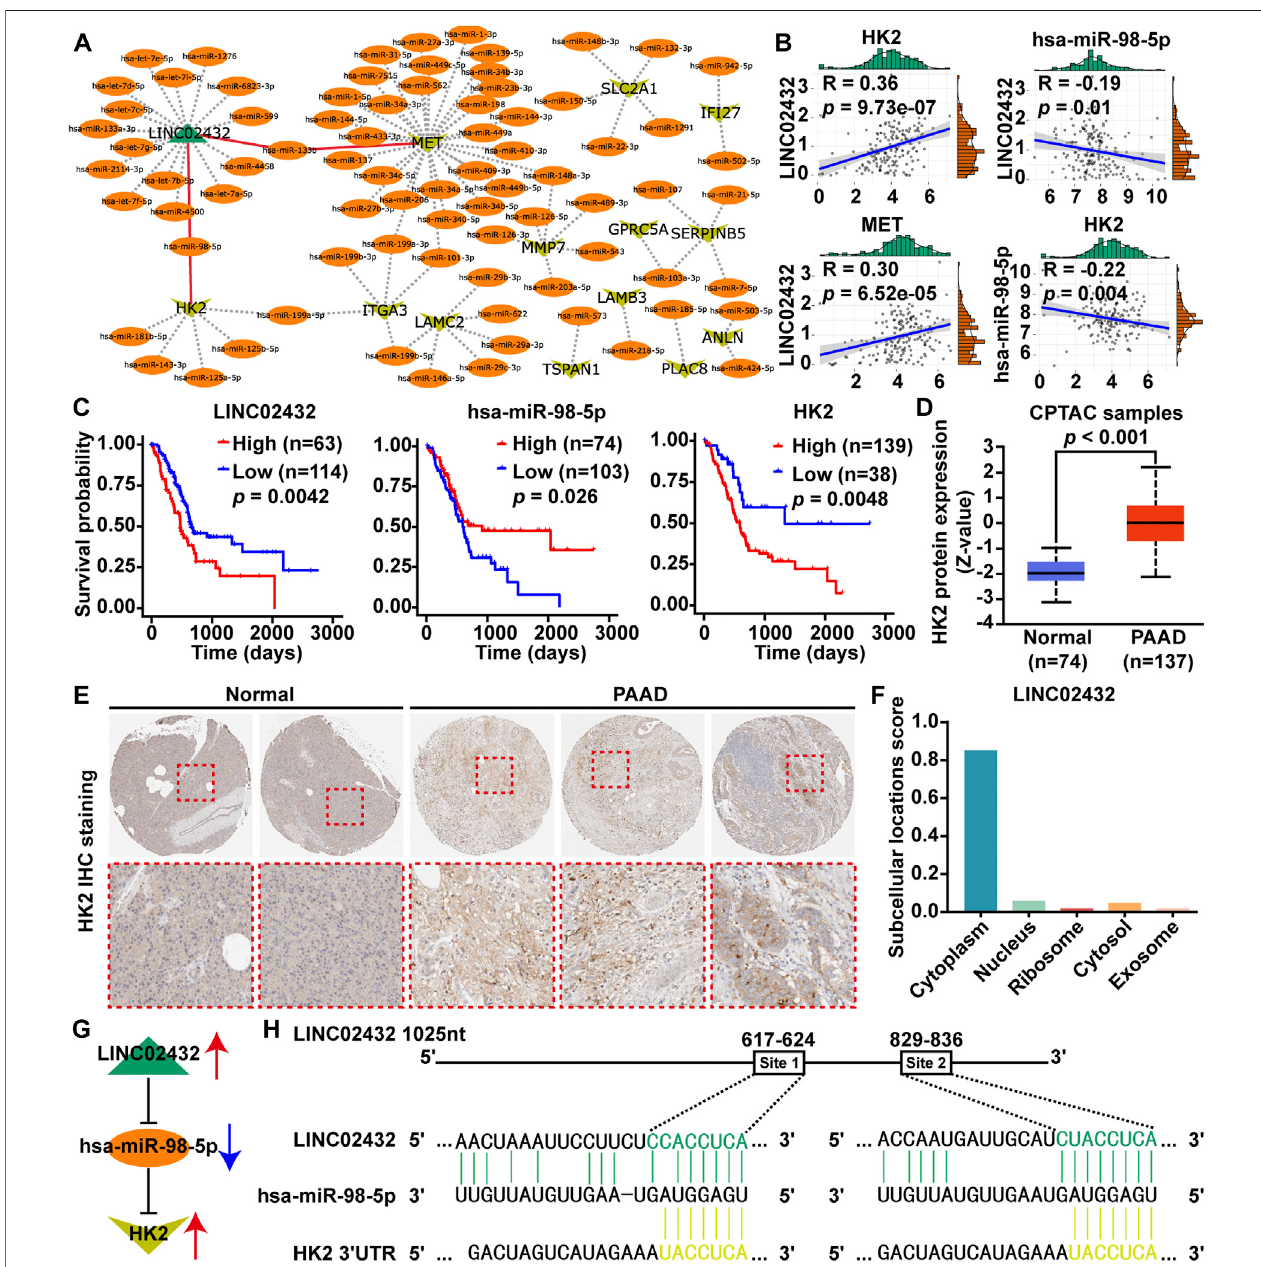
FIGURE2| Identi fi cationofglycolysis-relatedceRNAnetworkmodules. (A) AdiagramoflncRNA-miRNAandmRNA-miRNAinteractivenetworkswasconstructed byCytoscapesoftware. (B) ThePearsoncorrelationanalysiswasperformedtoidentifythecorrelationbetweengenes(LINC02432,HK2,MET,andhsa-miR-98 – 5p). (C) Survival analysis of LINC02432, hsa-miR-98 – 5p and HK2 was performed using Kaplan-Meier survival curves. (D) HK2 protein expression of PAAD patients was evaluated in the CPTAC datasets via the UALCAN database. (E) IHC staining of HK2 protein was analyzed in the HPA database. (F) Subcellular localization of LINC02432 was predicted using the lncLocator website. (G) Schematic illustration of the LINC02432/hsa-miR-98 – 5p/HK2 ceRNA axis. (H) Identi fi cation of target sites for hsa-miR-98 – 5p on the 3 ′ -UTR of LINC02432 and HK2.